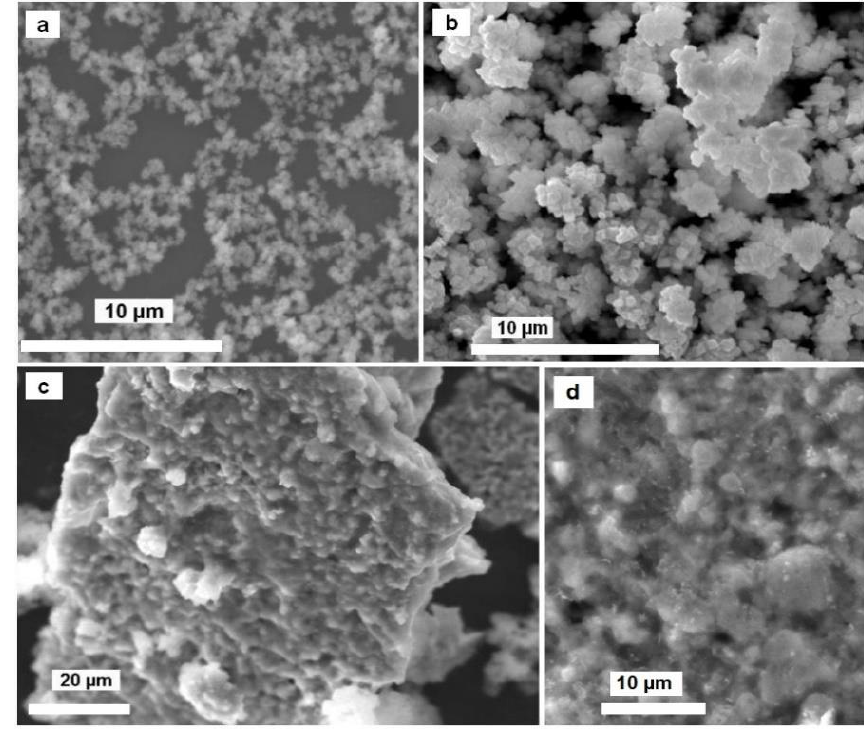
Figure 2. SEM images of as-prepared precursor powders: ( a ) sample A , ( b ) sample B and ( c , d ) sample A after ammonolysis reaction (4 h, 300 C sample 1b ).